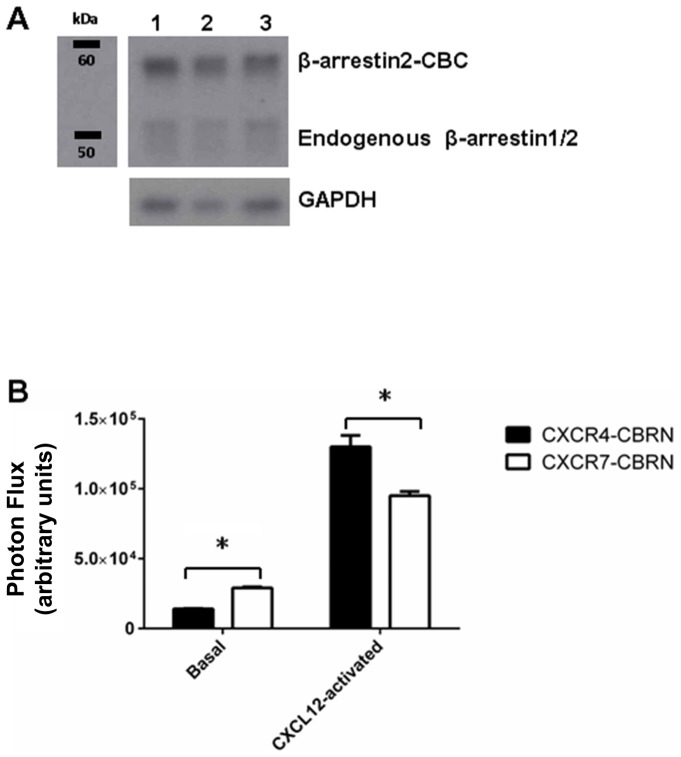
Luciferase complementation system reports on association of CXCR4 or CXCR7 with β-arrestin 2.(A) Expression of stably transduced β-arrestin 2-CBC and endogenous β-arrestin 1/2 in total lysates were detected by Western blot. Blots were stripped and re-probed for GAPDH as a loading control. Lane 1, CXCR4-CBRN/β-arrestin 2-CBC; lane 2, CXCR7-CBRN/β-arrestin 2-CBC; lane 3, CXCR4-CBRN/CXCR7-CBGN/β-arrestin 2-CBC. (B) Bioluminescence in CXCR4-CBRN/β-arrestin 2-CBC and CXCR7-CBRN/β-arrestin 2-CBC cells was measured under basal conditions and 18 minutes after adding 1000 ng/ml CXCL12-α. Graph shows mean values for photon flux arbitrary units + SEM for CXCR4+ or CXCR7+ cells (n = 4 per condition). *, significant difference.